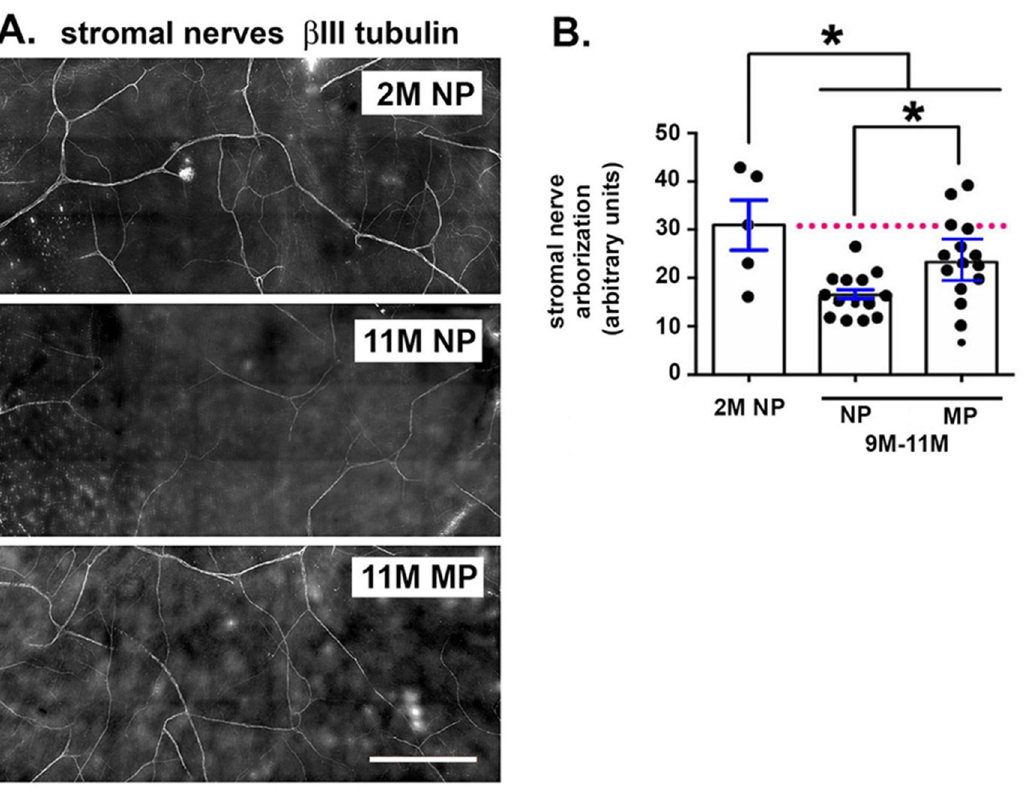
Figure 4. Age-related loss of stromal nerve arborization is partially attenuated in multiparous mice. Stromal nerve arborization was assessed at 2M in NP and at 9M, 10M, and 11M in NP and MP mice. Five corneas are assessed for each time point. ( A ) Representative stromal nerve images for 2M and 11M NP and 11M MP are presented. ( B ) Data for each variable are clustered for 9–11M NP and MP female mice and compared to data for 2M NP mice. Asterisks indicate significant differences with p values < 0.05. The dotted pink line highlights axon density for 2M NP controls. Bar = 500 μ m.